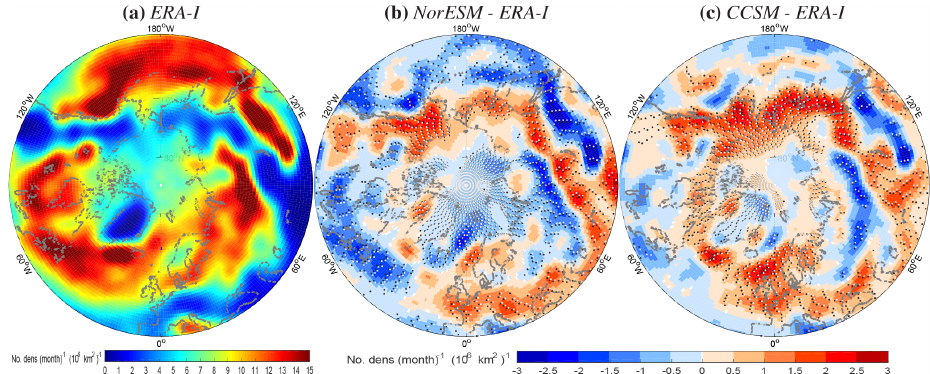
Figure 7. Track density average for SOND 1979–2005 in (a) ERA-I and bias of (b) NorESM and (c) CCSM compared to ERA-I. Alternating black and white dots in panels (b) and (c) mark regions where p < 0 . 05 based on 2000